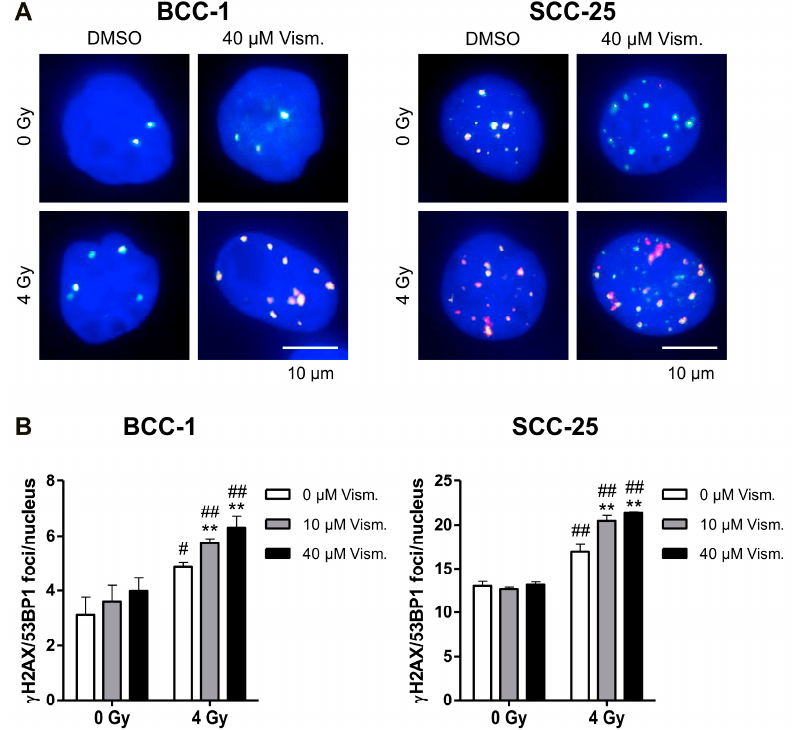
Figure 4. Vismodegib increases radiation-induced γ H2AX/53BP1 nuclear foci. BCC-1 or SCC-25 cells were treated for 24 h with 10 or 40 µM vismodegib or with DMSO as control followed by irradiation with 4 Gy. ( A ) Representative images of phosphorylated gamma histone-2AX ( γ H2AX)/p53-binding protein 1 (53BP1) foci from non-irradiated and 4 Gy-irradiated DMSO control versus 40 µM vismodegib-treated cells are shown. Nuclei were counterstained with DAPI. Scale bar, 10 µm. ( B ) Quantification of persistent γ H2AX/53BP1 foci in vismodegib treated and irradiated BCC-1 (left panel) and SCC-25 (right panel) cells. Bars represent means + SD from three independent experiments performed in duplicate. ** p < 0.01 vismodegib- versus DMSO-treated cells and # p < 0.05, ## p < 0.01 4 Gy versus non-irradiated cells ( t -test). Gy, Gray; Vism., vismodegib.